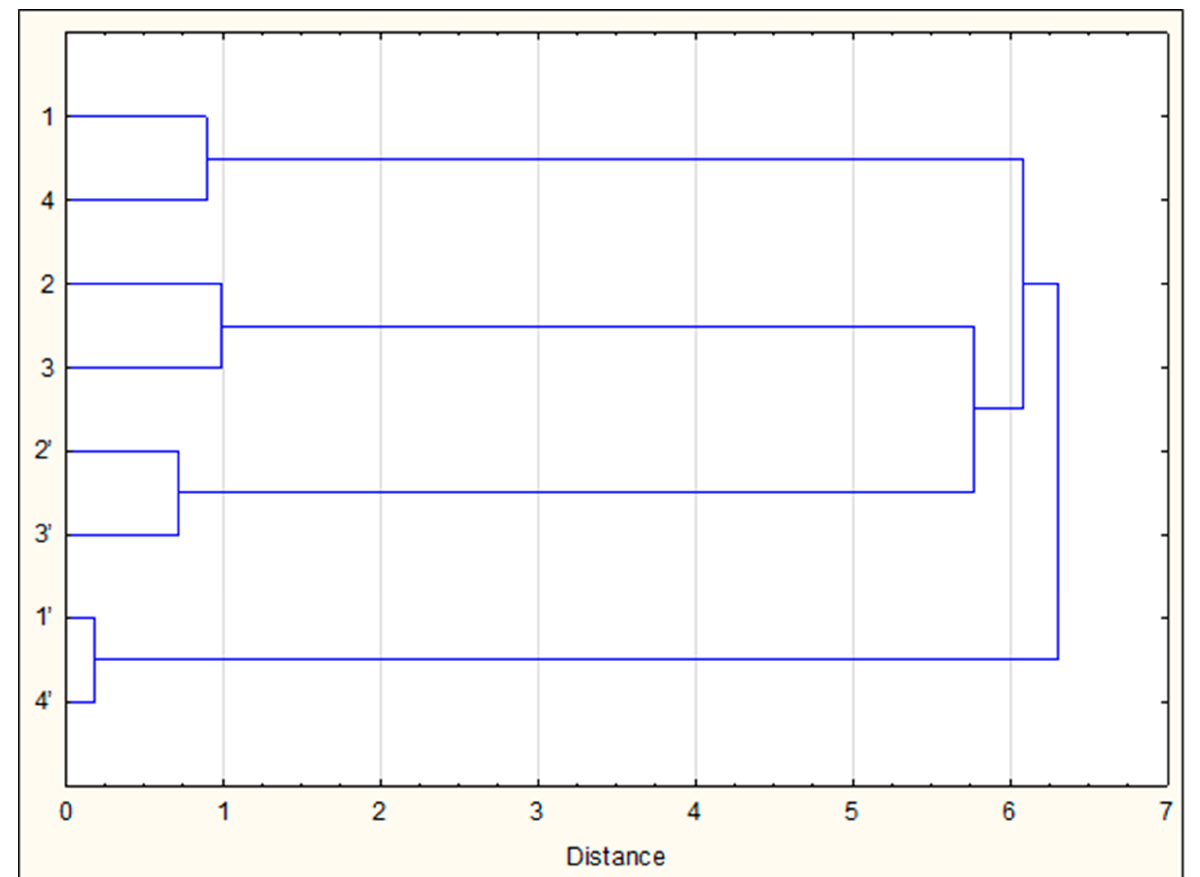
Figure 3. Dendrogram of the chemical similarity of VOCs (1–4) and ether extracts (1’–4’) of the study of SLB propolis samples.